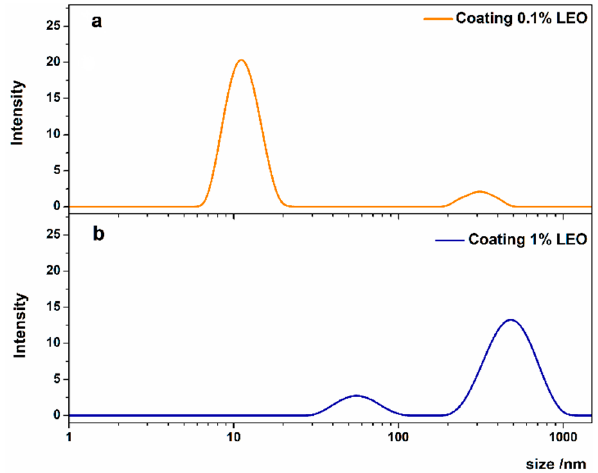
Figure 1. Size distributions of alginate based nanoformulations containing 0.1% LEO ( a ) or 1% LEO ( b ).